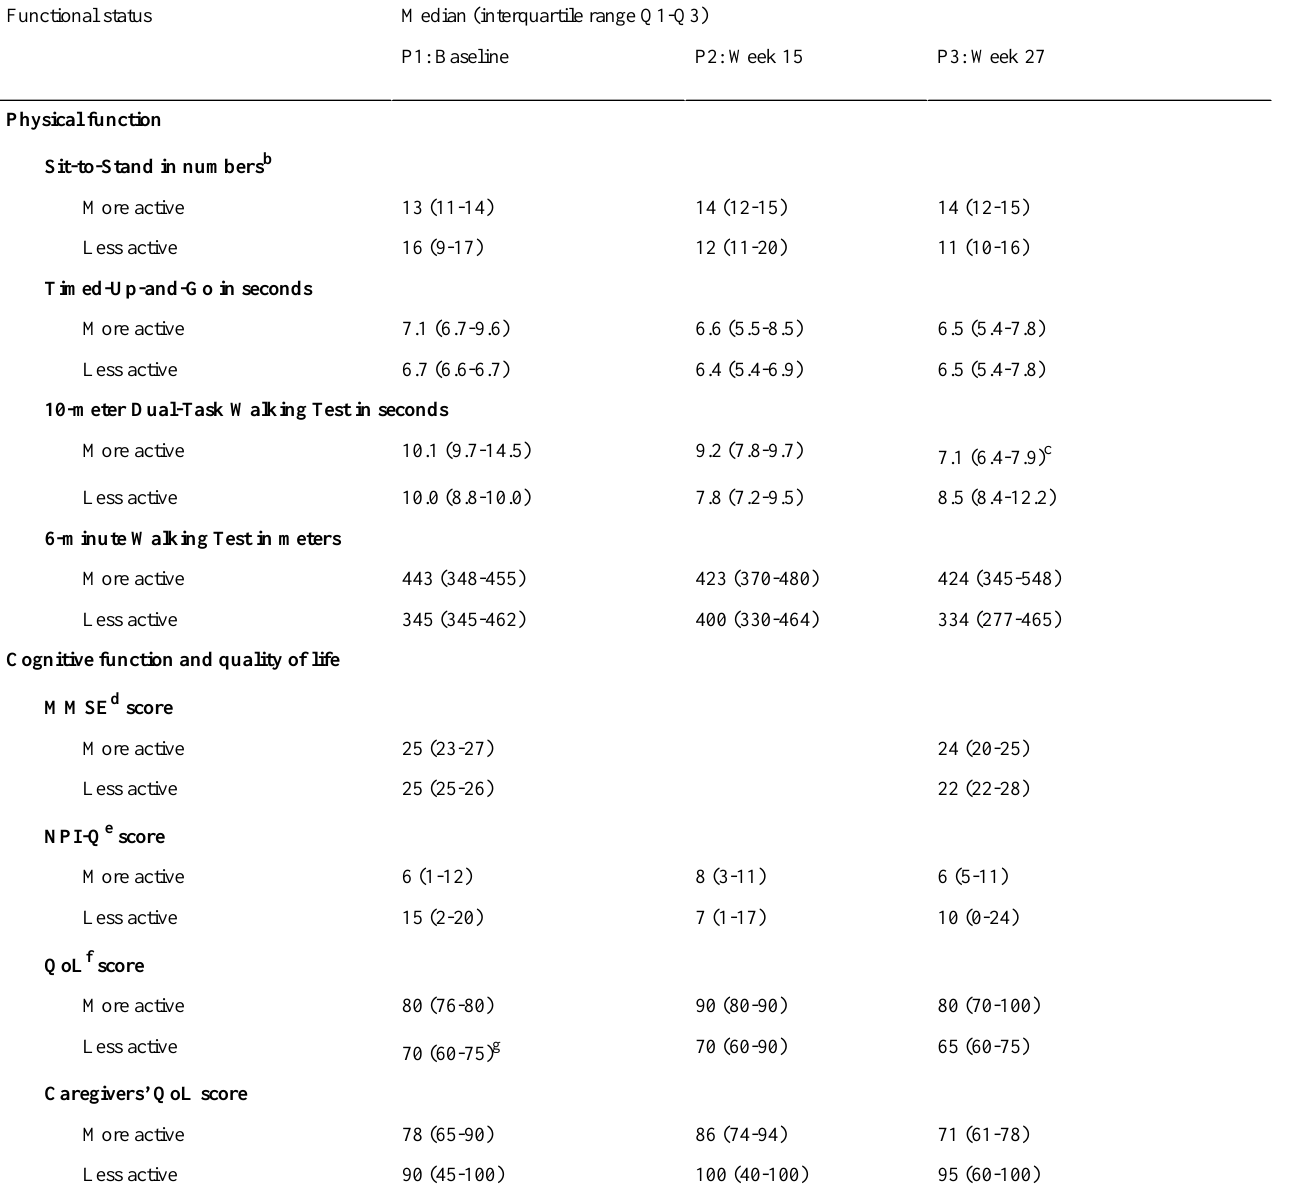
Table 4. Physical and mental function of participants who more actively (n=6) and less actively (n=3) used MBT a at home.